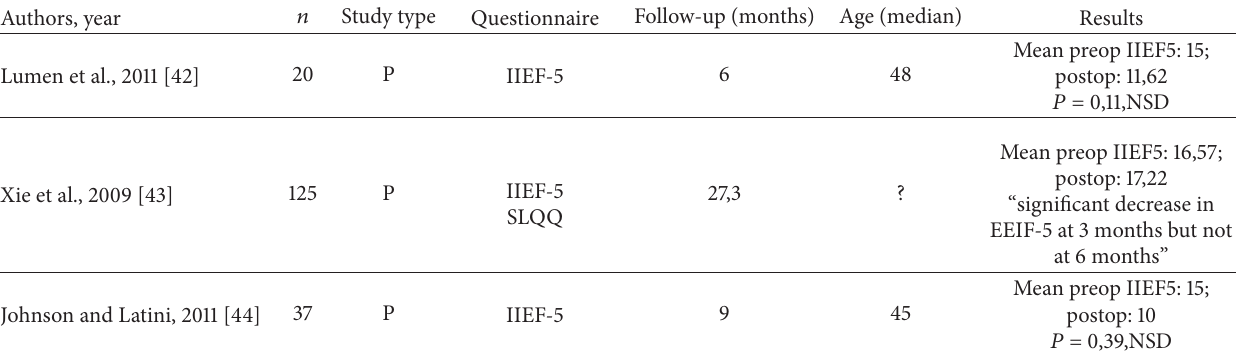
Table 3: Anterior and posterior urethra, erectile dysfunction: other prospective